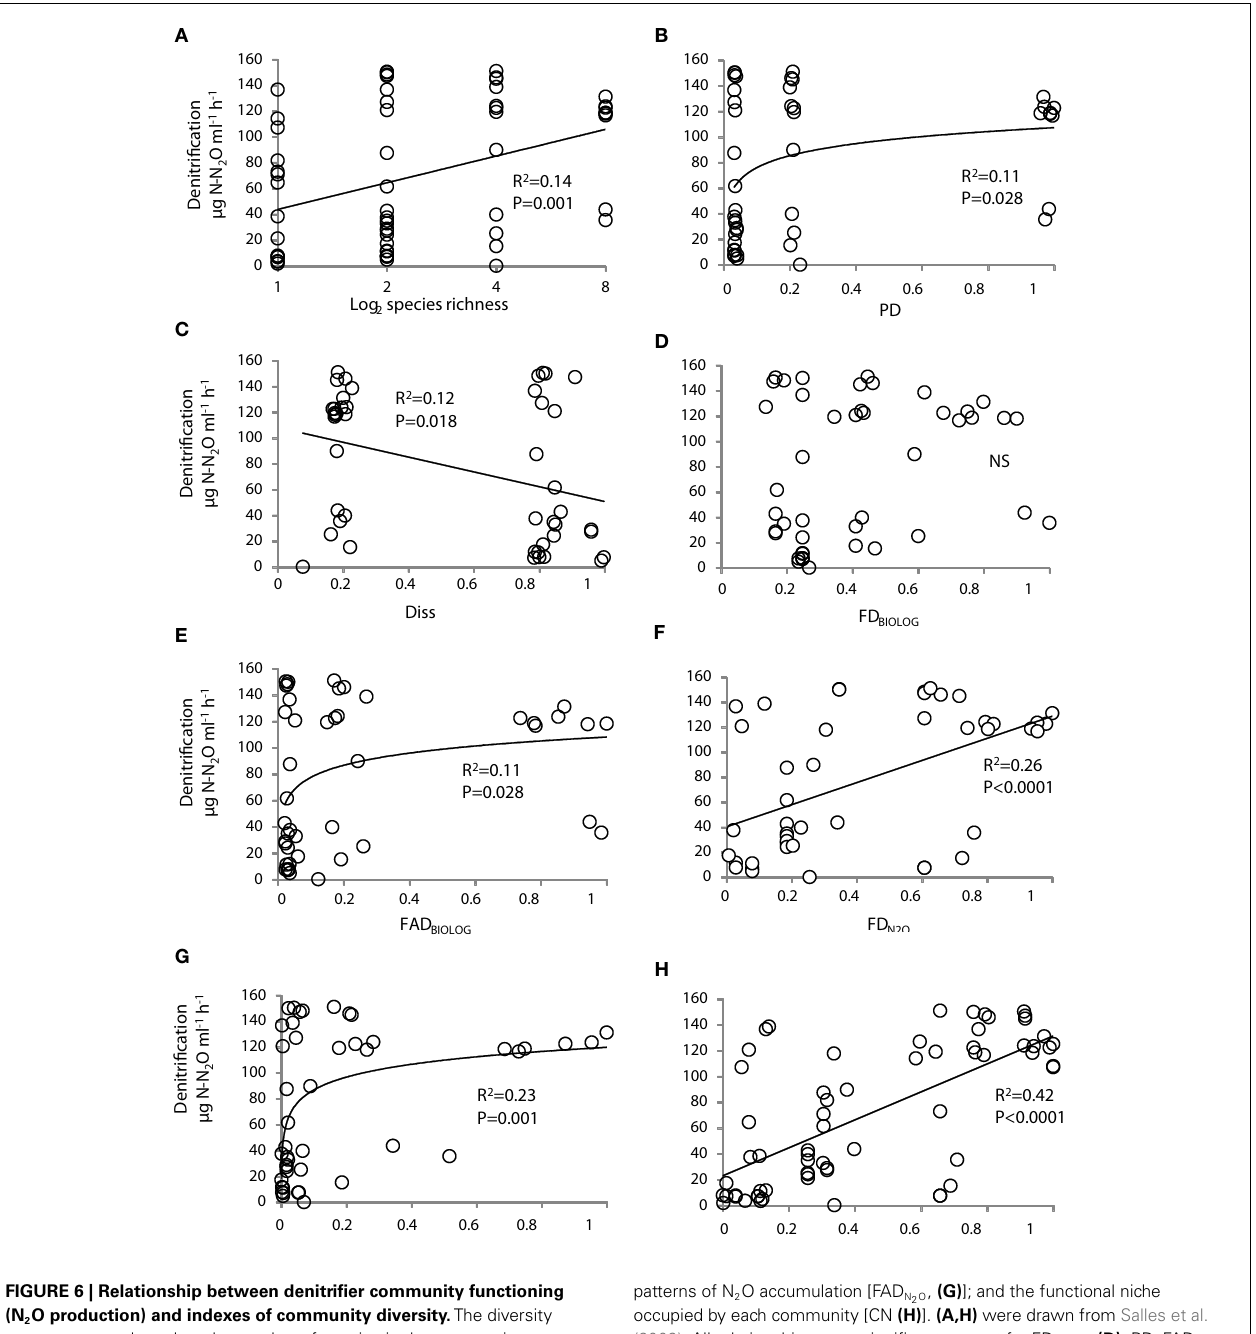
patterns of N 2 O accumulation [FAD N2O , (G) ]; and the functional niche occupied by each community [CN (H) ]. (A,H) were drawn from Salles et al. (2009). All relationships were significant, except for FD BIOLOG (D) . PD, FADs, FDs, and community niche were standardized by dividing them by the maximum values observed across all communities. Diss, CN, and FD represent linear regressions; the remaining figures show a logarithmic regression. S, Species richness; PD, phylogenetic diversity; Diss, Dissimilarity; CN, Community niche; FAD, Functional Attribute